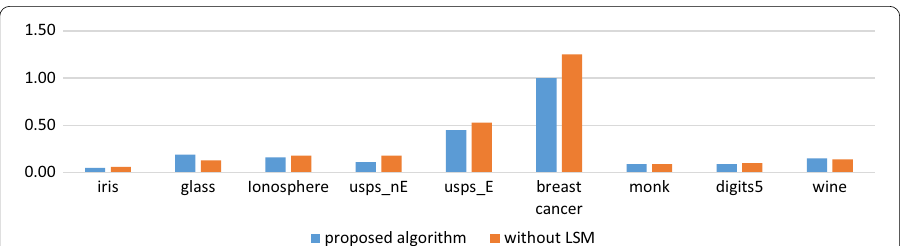
Fig. 10 Average classification runtime of proposed method with and without LSM on evaluation